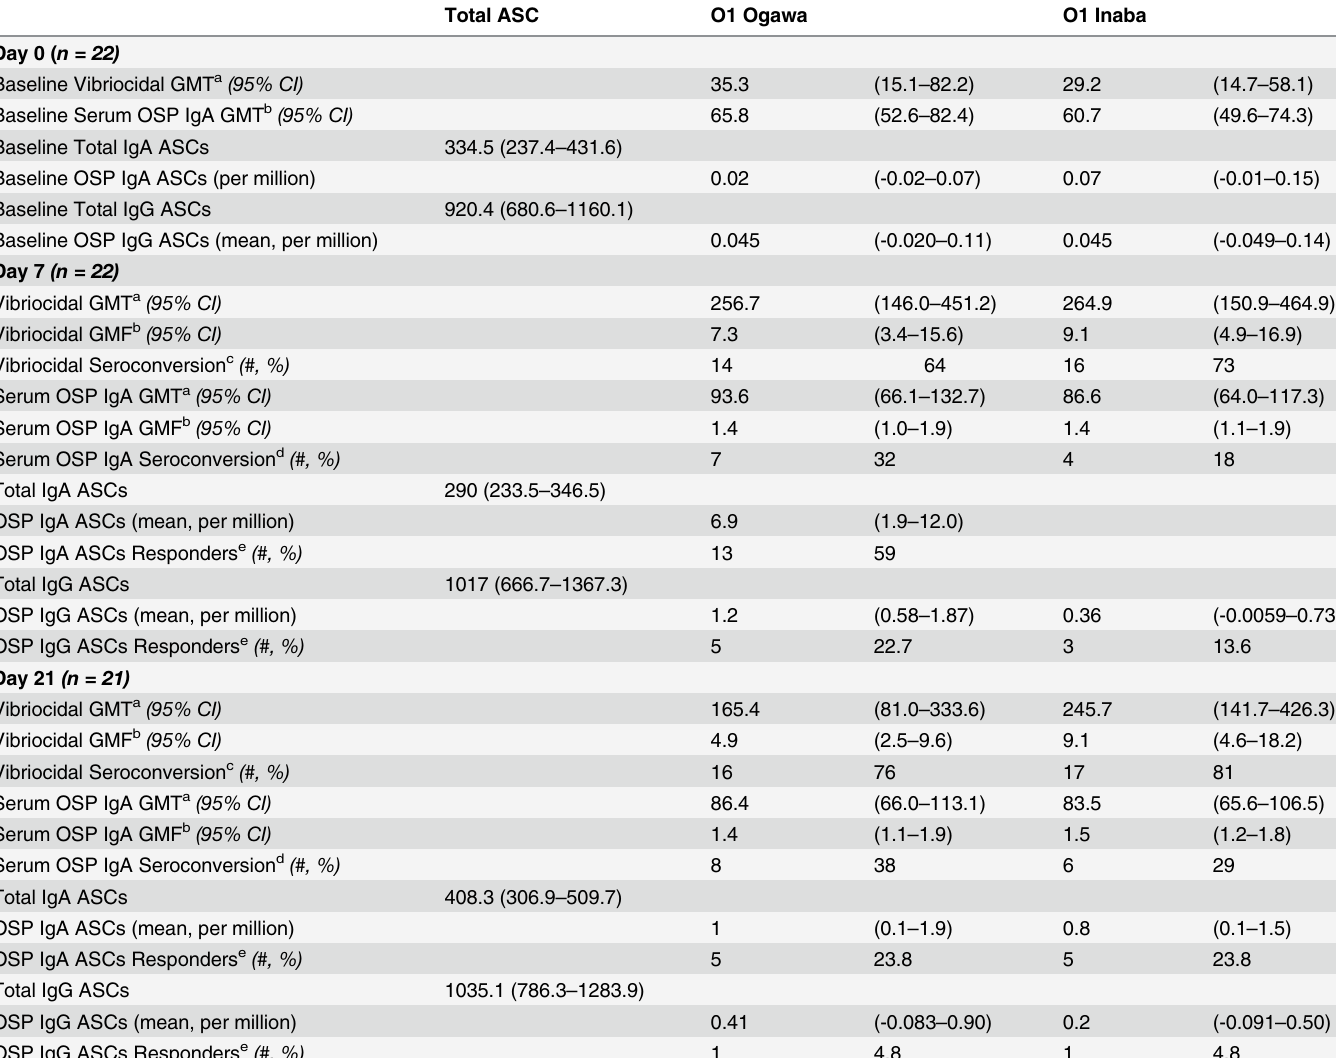
Table 2. Immune responses to V. cholerae (O1 Ogawa and O1 Inaba) following vaccination with BivWC. Total ASC O1 Ogawa O1